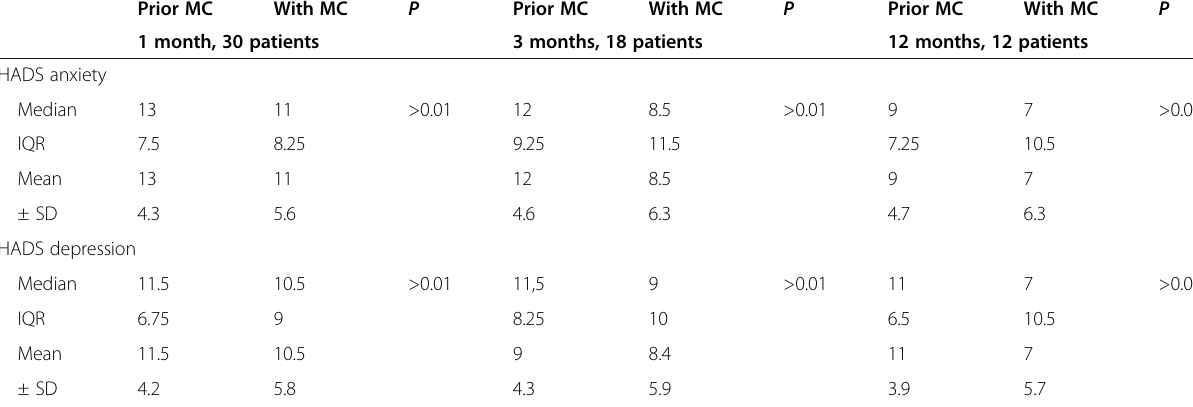
Table 9 Medical cannabis effects on mood disorders at 1, 3, and 12 months in Italian fibromyalgia